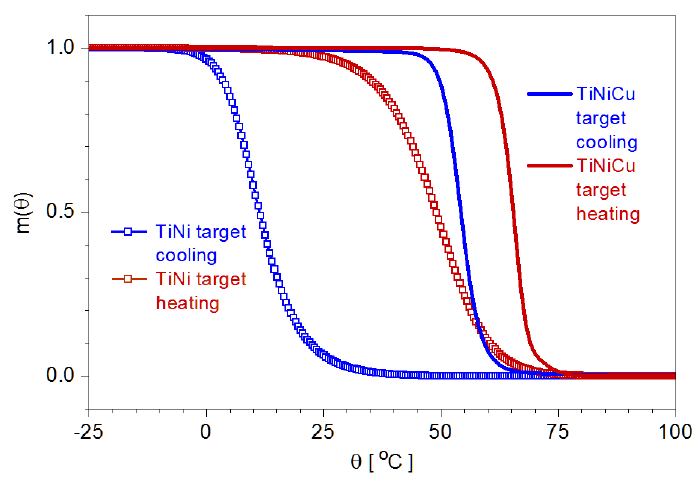
Figure 4. DSC records of the MPT in the target alloys used for experiments: Ti-Ni, showing the B2 → B19’ transition, and Ti-Ni-Cu, showing the B2 → B19 transition.